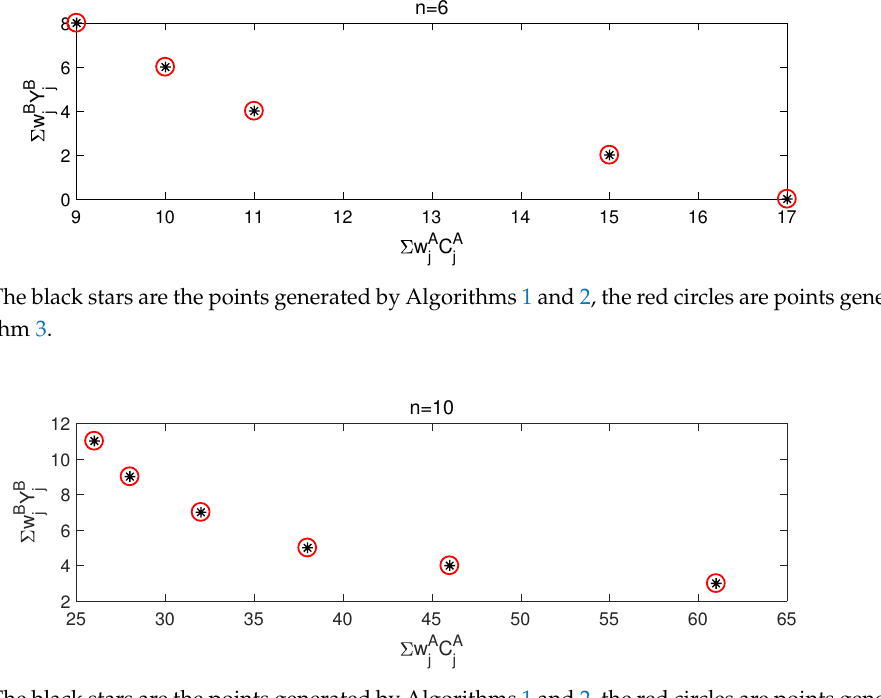
Figure 3. The black stars are the points generated by Algorithms 1 and 2, the red circles are points generated by Algorithm 3.